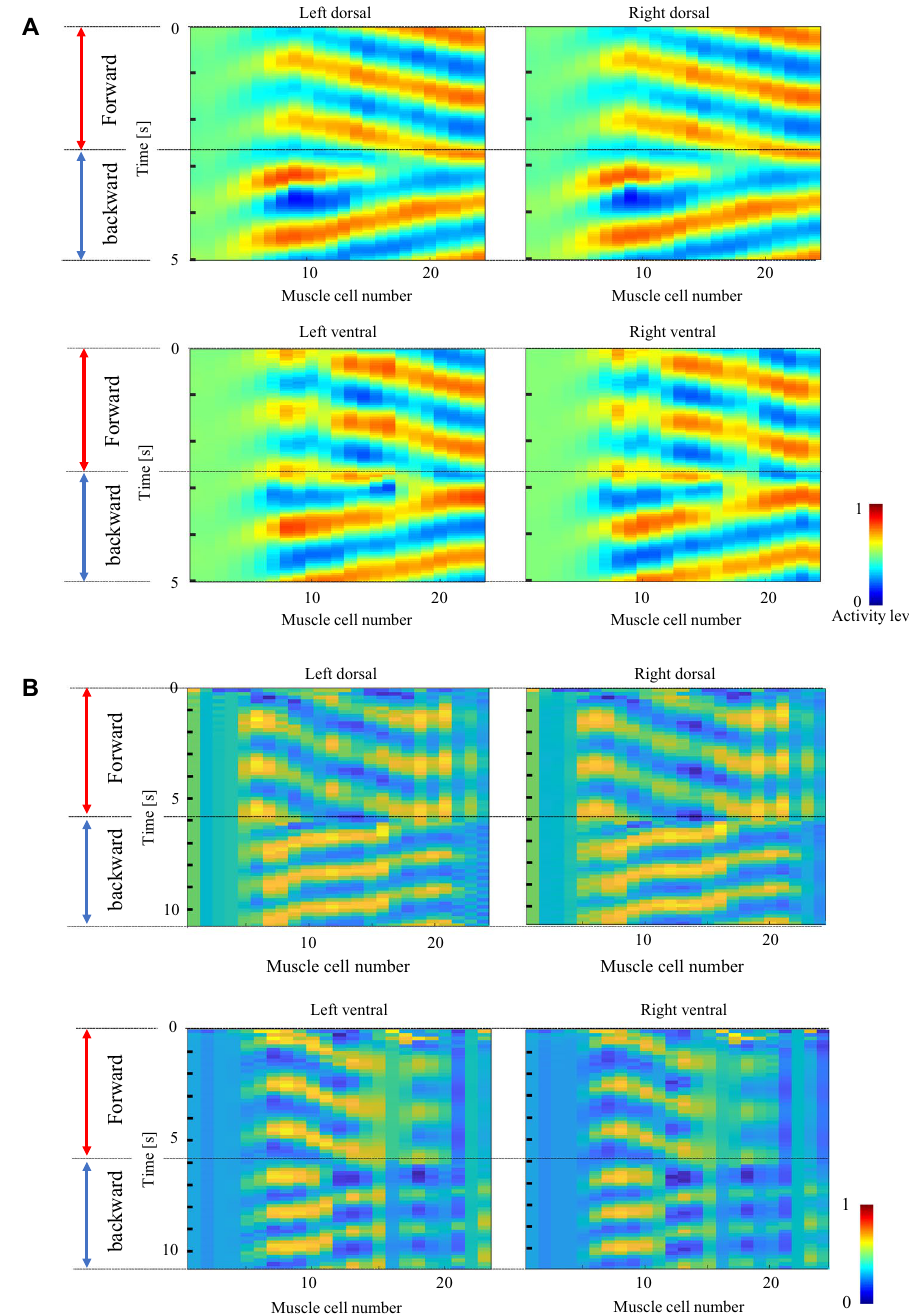
Figure 7. Muscle activities generated by the trained input. The phases of the muscle activity are reversed as the inputs of the command neurons change. The four muscles from the head in each quadrant, controlled by the nerve ring, fail to generate oscillation patterns. In ( A ), the model is trained by the teacher data generated from Eqs. (9)–(11). In ( B ), the model is trained by the teacher data generated from the measured muscle